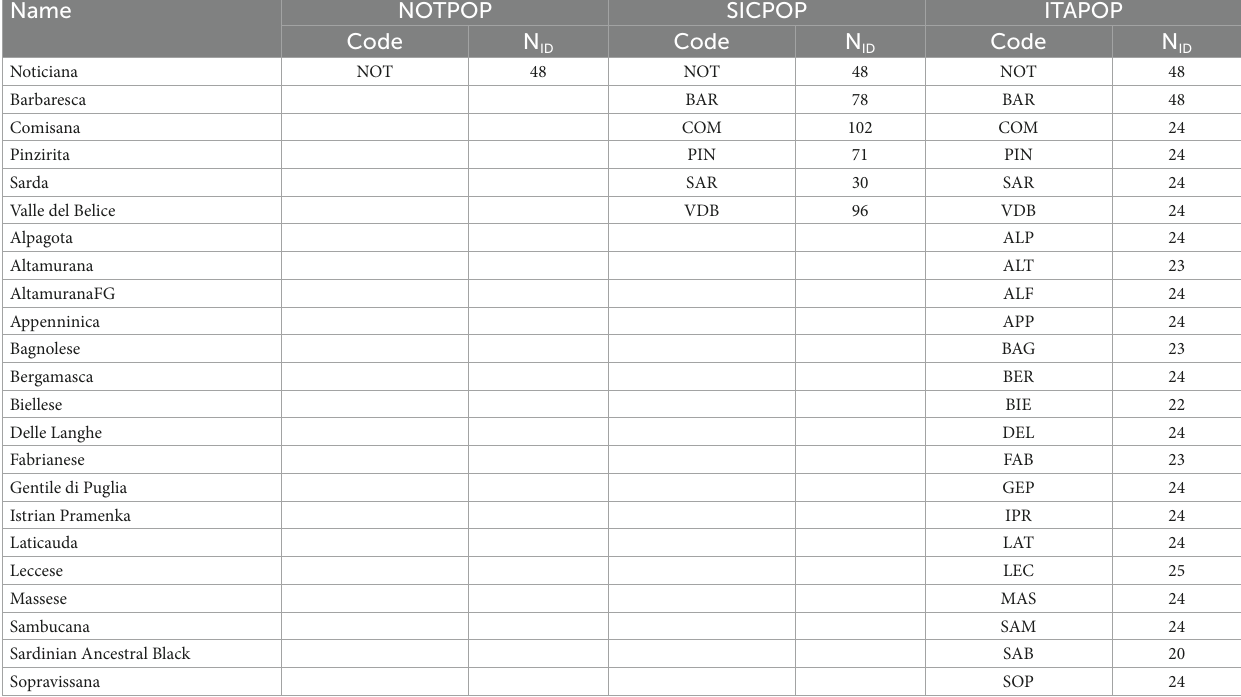
TABLE 1 Breeds, acronyms (code) and number of individuals (N ID ) involved in the analyses explicated for all the datasets after quality